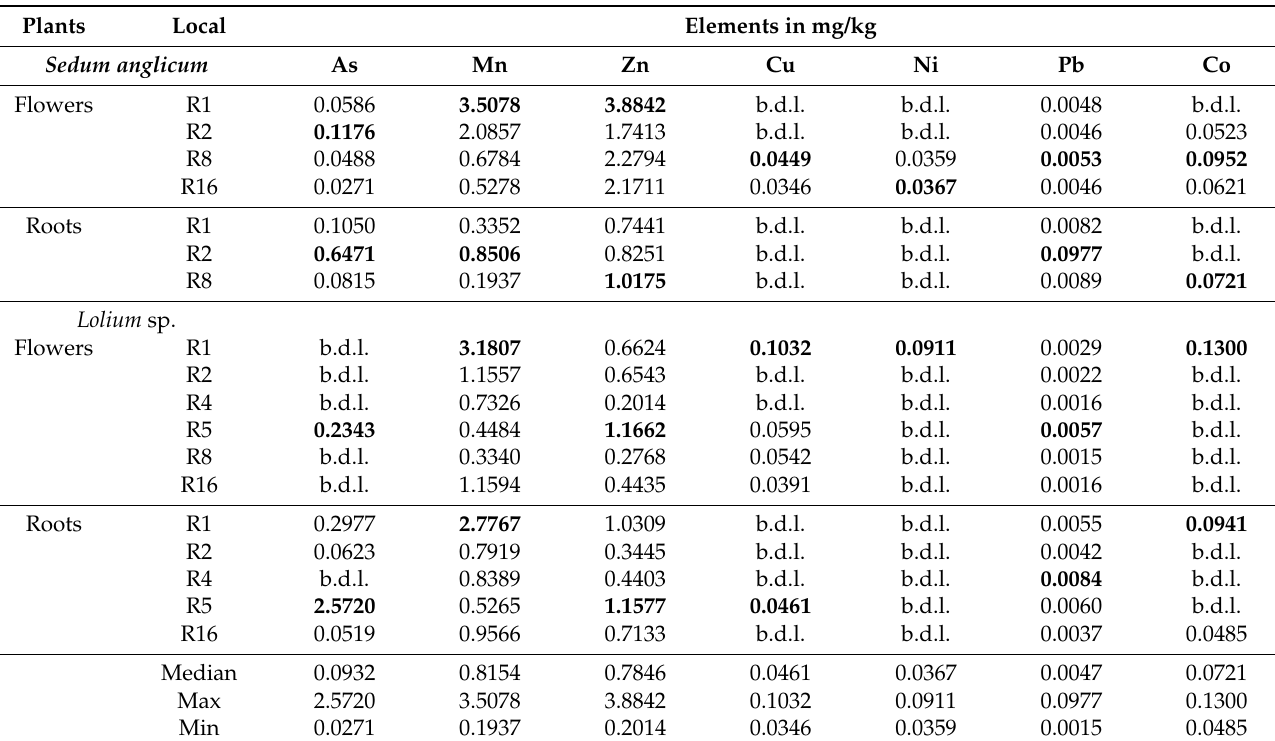
Table 2. Concentration (mg/kg) in the studied plants, collected at Regoufe’s mine main valley, of the potentially toxic elements—PTEs (mg/kg) measured in the soil surface samples. For each element, the highest values are highlighted in bold; b.d.l.—below the detection